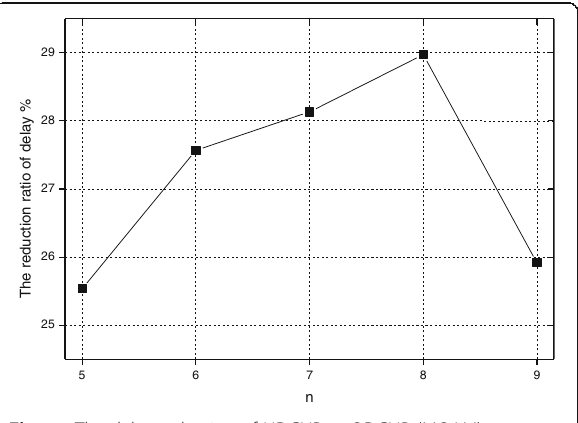
Fig. 15 The total energy consumption under UDCNP and ODCNP